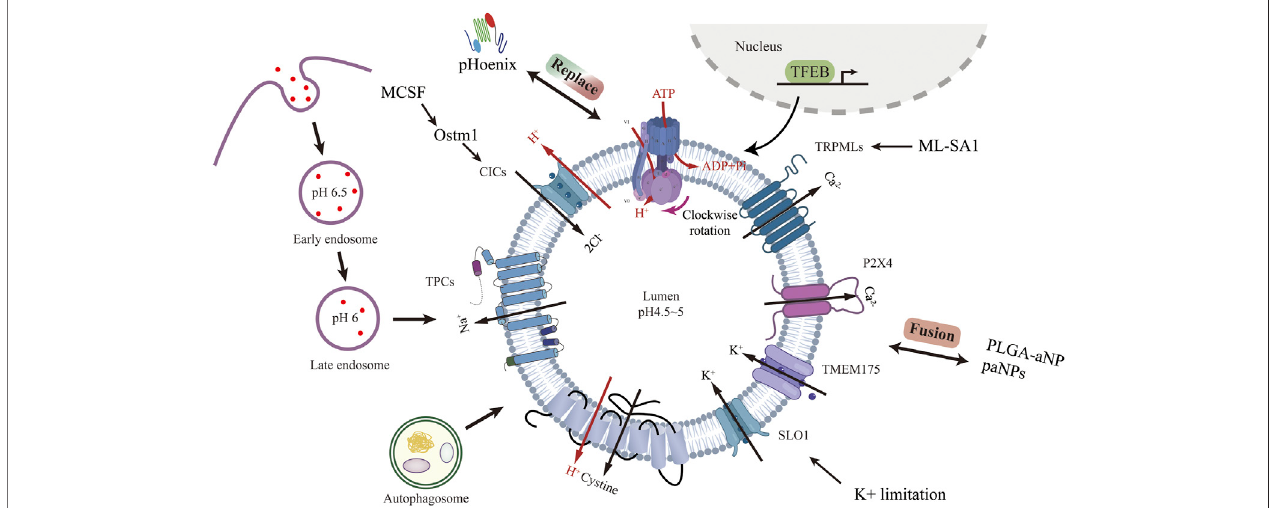
FIGURE 1 | Lysosomal acidi fi cation process and regulatory strategies targeting channel proteins other than V-ATPase. Created with BioRender.com.